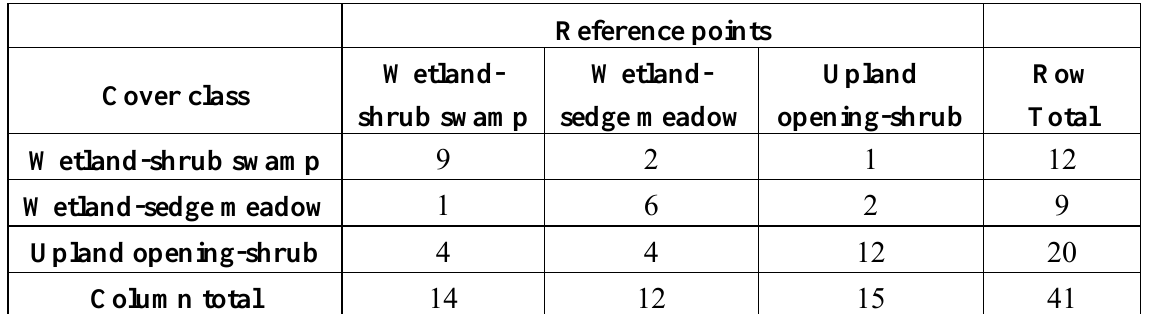
Table 3B. The error matrix of the uncorrected image (image 2) for Nicolet vegetation cover.